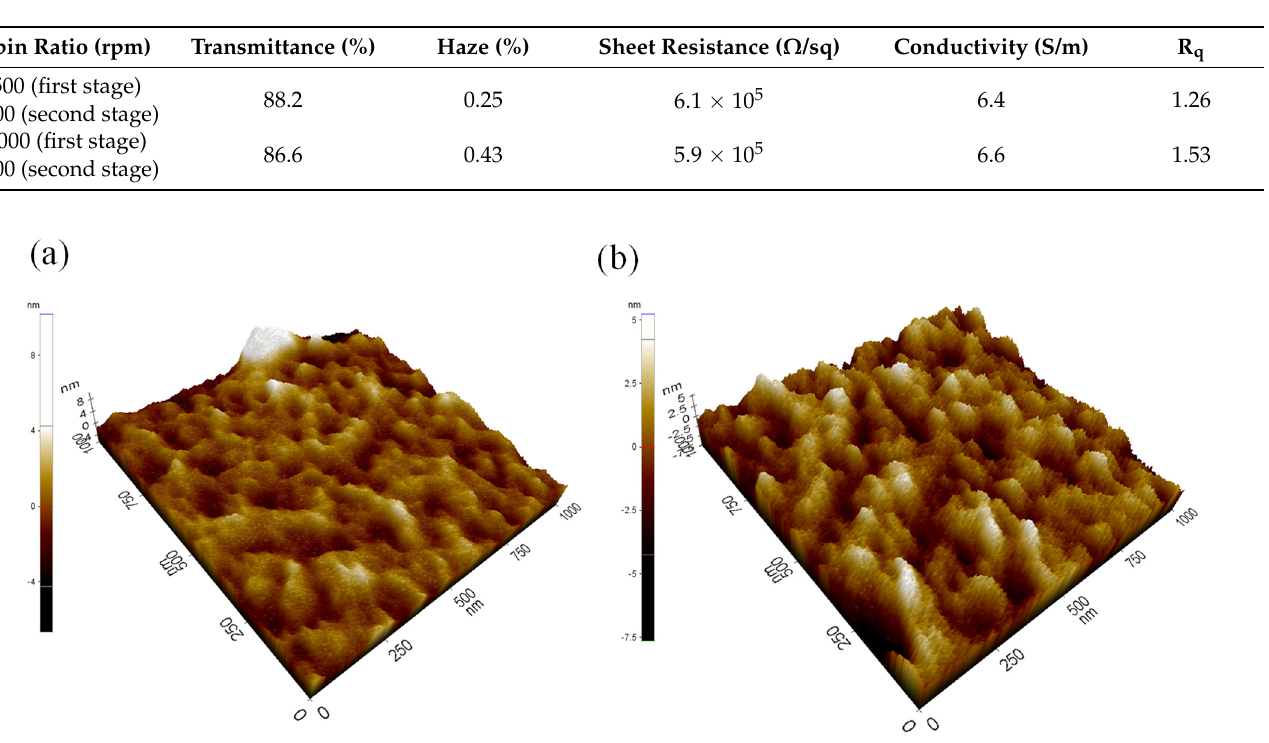
Table 1. Transmittance, haze, sheet resistance, conductivity, and R q of different pre-coating speeds for PEDOT: PSS films.